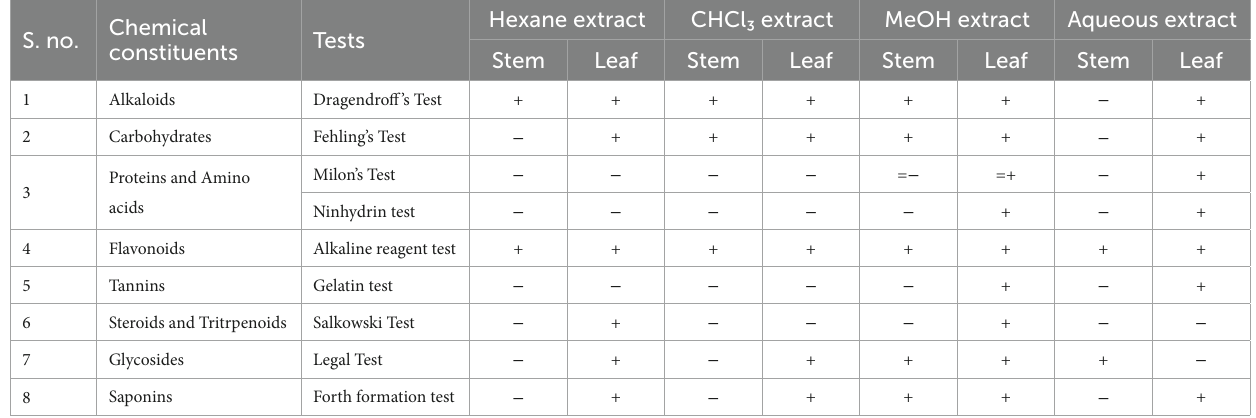
TABLE 2 Phytochemical screening of various extracts of T. cordifolia .